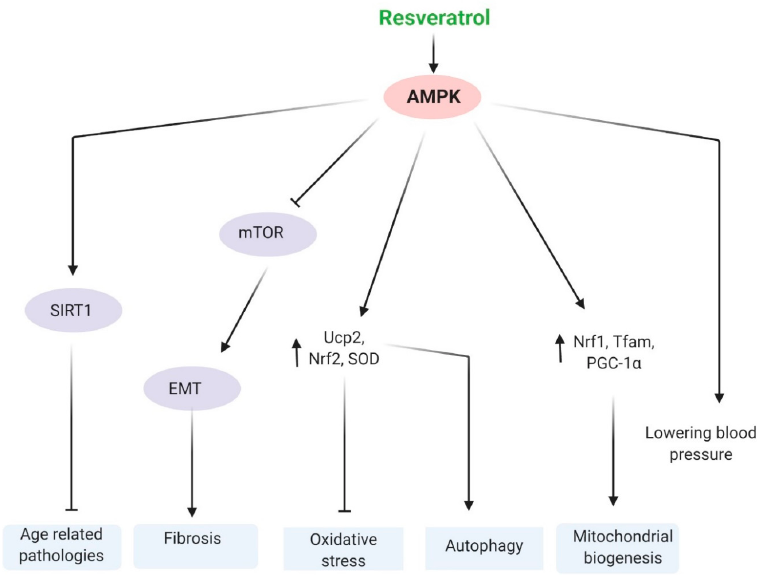
Figure 3. Resveratrol-induced AMPK is associated with the modulation of various mechanisms of age-related pathologies. Resveratrol-induced AMPK activates SIRT1, leading to the inhibition of many age-related pathologies. AMPK suppresses EMT and fibrosis through inhibition of mTOR. Nrf2, and SOD expression, which is associated with the activation of autophagy and the suppression of oxidative stress. Additionally, AMPK lowers blood pressure and increases mitochondrial biogenesis- related genes, such as Nrf1, Tfam, and PGC-1 α . All of these pathways mediated by resveratrol- induced AMPK are associated with the anti-aging process. AMP-activated protein kinase, AMPK; epithelial–mesenchymal transition, EMT; sirtuin type 1, SIRT1; mammalian target of rapamycin, mTOR; mitochondrial uncoupling protein2 (UCP2); nuclear factor erythroid 2–related factor 2 (Nrf2); peroxisome proliferator-activated receptor- γ coactivator-1 α , PGC-1 α ; and mitochondrial transcription factor A, Tfam. Arrow means activation, and ‘T’ arrow means